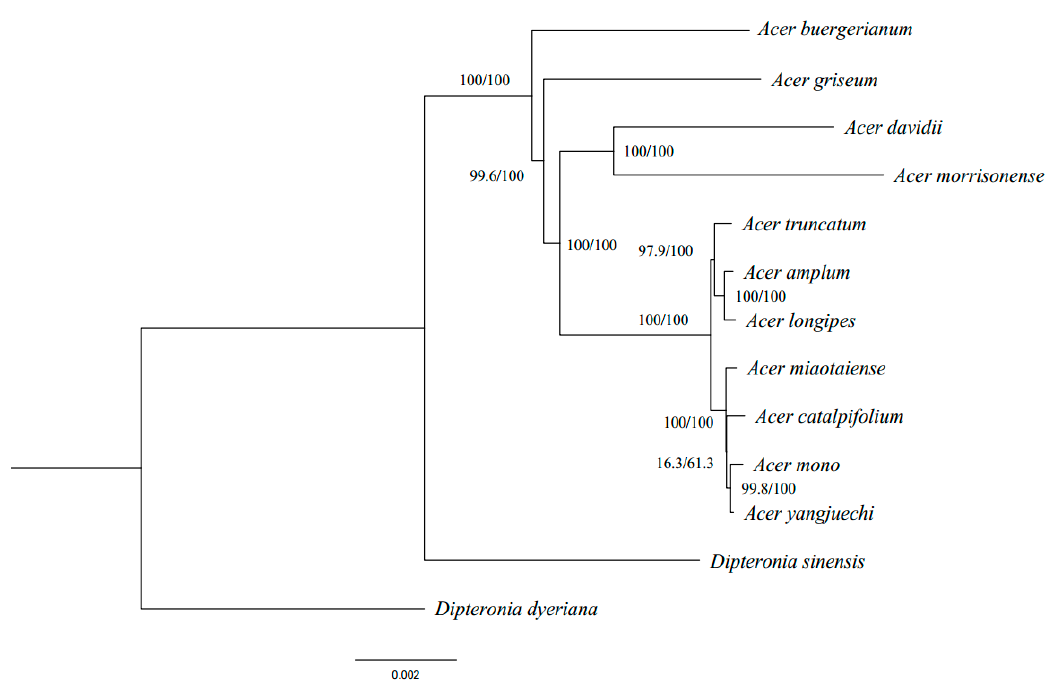
Figure 4. Phylogenetic tree of 13 Acer species inferred by Maximum Likelihood (ML) and Bayesian Inference (BI) methods, based on the whole cp genome sequences. The numbers above the branches are the bootstrap values of ML methods and the posterior probabilities of BI.